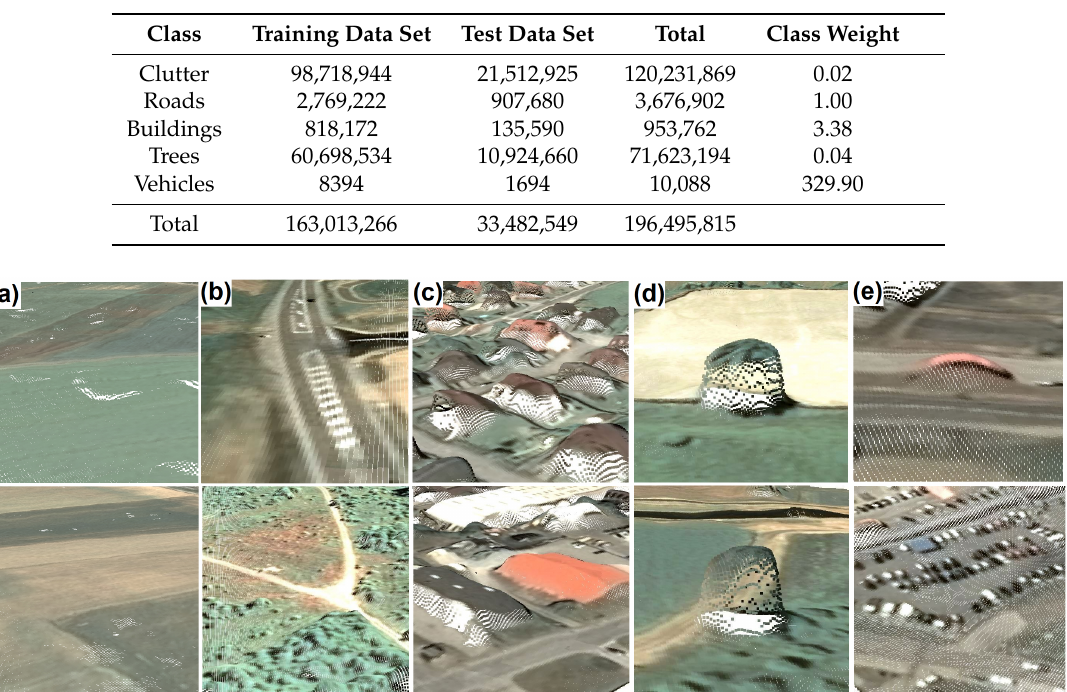
Figure 3. Relative occurrence of the classes in the training (red) and test (green) set: the magnitude of class imbalance is here highlighted as the vehicle bars are not visible ( left ); and by changing the scaling, they are visible ( right ). Table 2. Quantitative comparison of the training data set with the test set. The right column shows the class weights based on the training set.